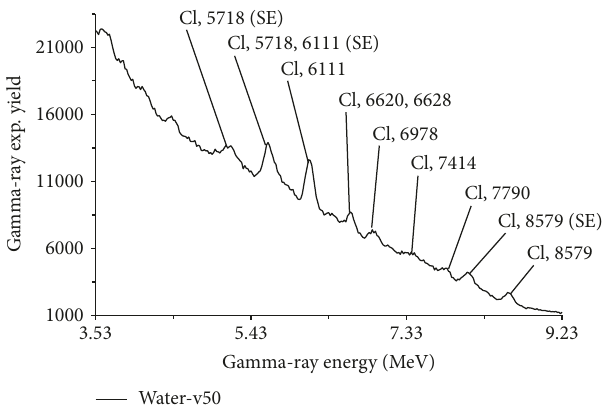
Figure 3: Prompt gamma-ray spectrum due to activation of the LaCl3:Ce detector caused by the capture of thermal neutrons in La, Ce, and Cl in LaCl3:Ce detector material over 3.53 – 9.23MeV range.